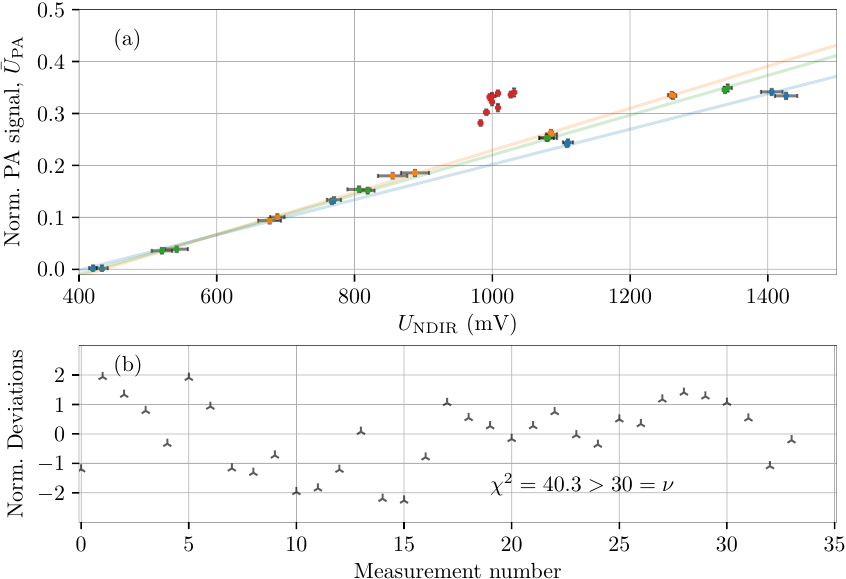
Figure 3. Calibration of a PA sensor of CO 2 in humid gas samples. ( a ) acquired PA signal for a wide range of CO 2 - and absolute humidity levels, demonstrating the PA water-enhancement effect. The er- ror bars represent 1 σ standard deviations for each measurement point; ( b ) the normalized deviations, d i for each of the 34 measurand sets, acquired using the generalized least-squares algorithm